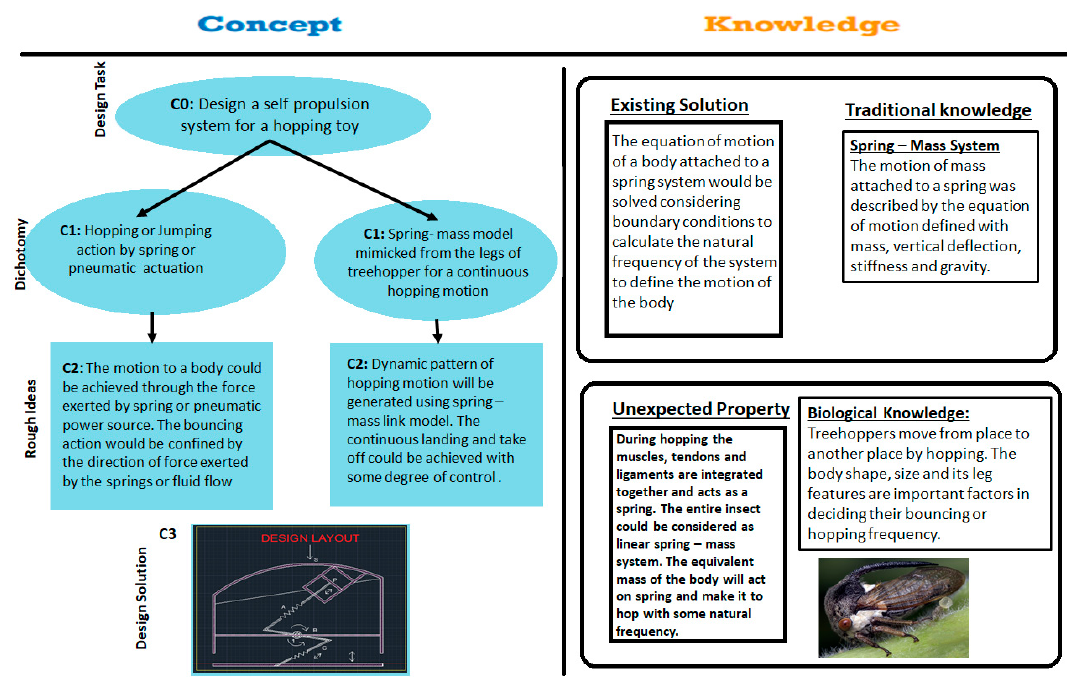
Figure 1. Example of bioinspired design solution in Concept-Knowledge space.